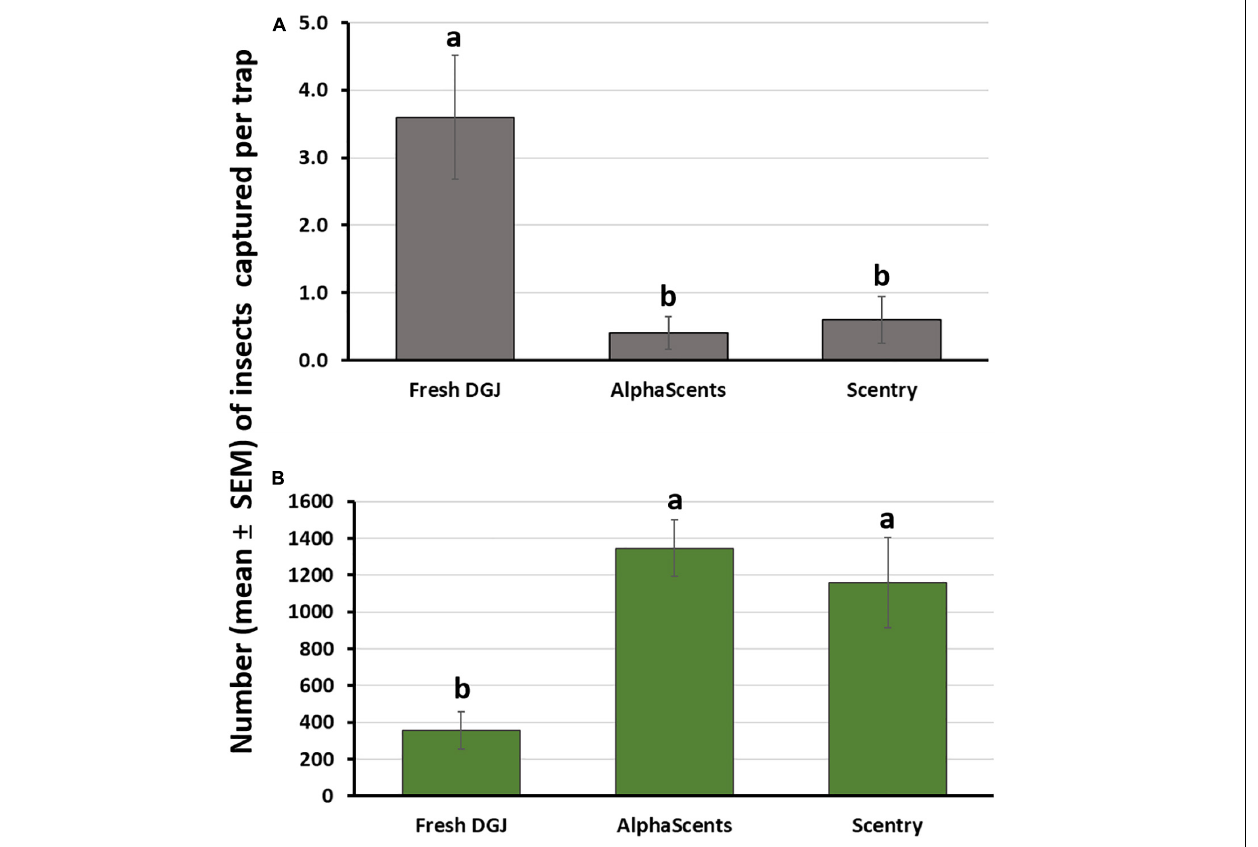
FIGURE 2 | Early season captures (means ± SEM) of (A) adult D. suzukii (male and females combined) and (B) other drosophilids in traps baited with fresh diluted Concord grape juice (DGJ), and two commercial lures. Study conducted in five Massachusetts locations from 17 May to 17 June 2019. Means superscribed by different letters denote significant differences according to ANOVA and HSD Tukey tests at P =